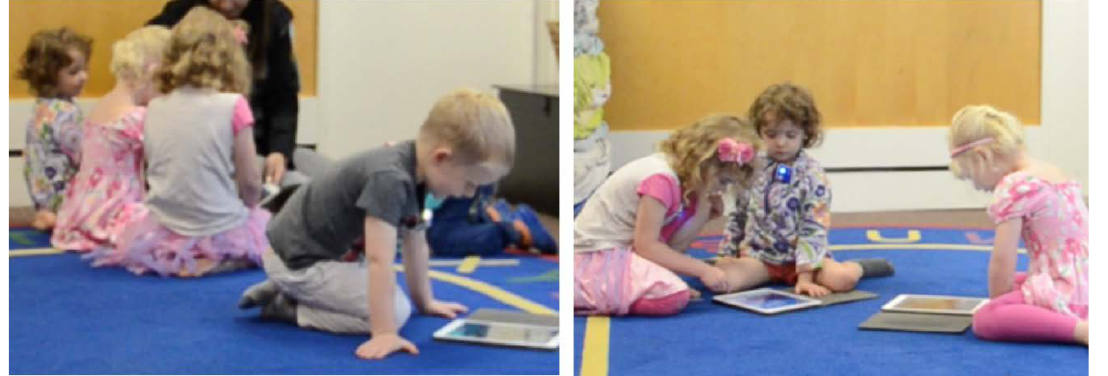
Figure 3. Participants 1 and 2 work independently while other participants work together.